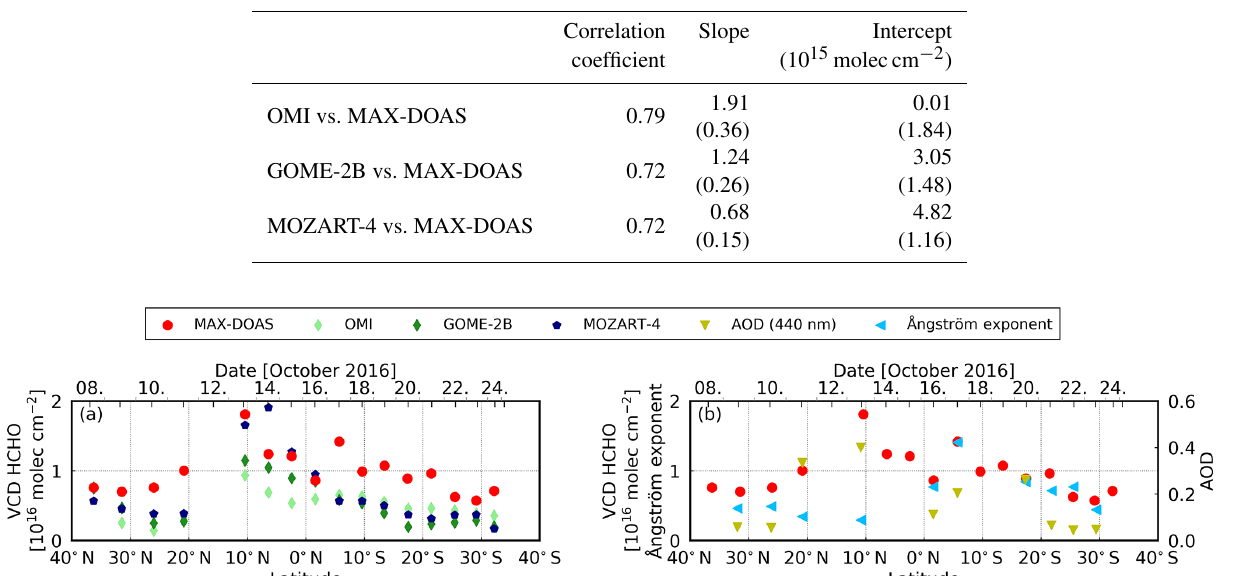
was used to exclude poor viewing conditions (see Sect.